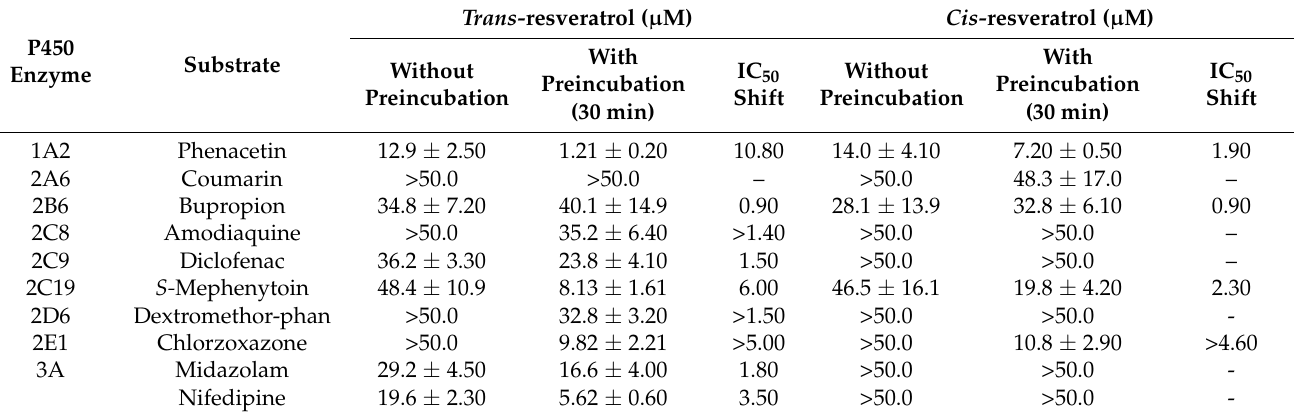
Table 2. Inhibitory effects (IC 50 values) of trans - and cis -resveratrol against nine cytochrome P450 isoforms (P450s) in HLMs ( n = 3).